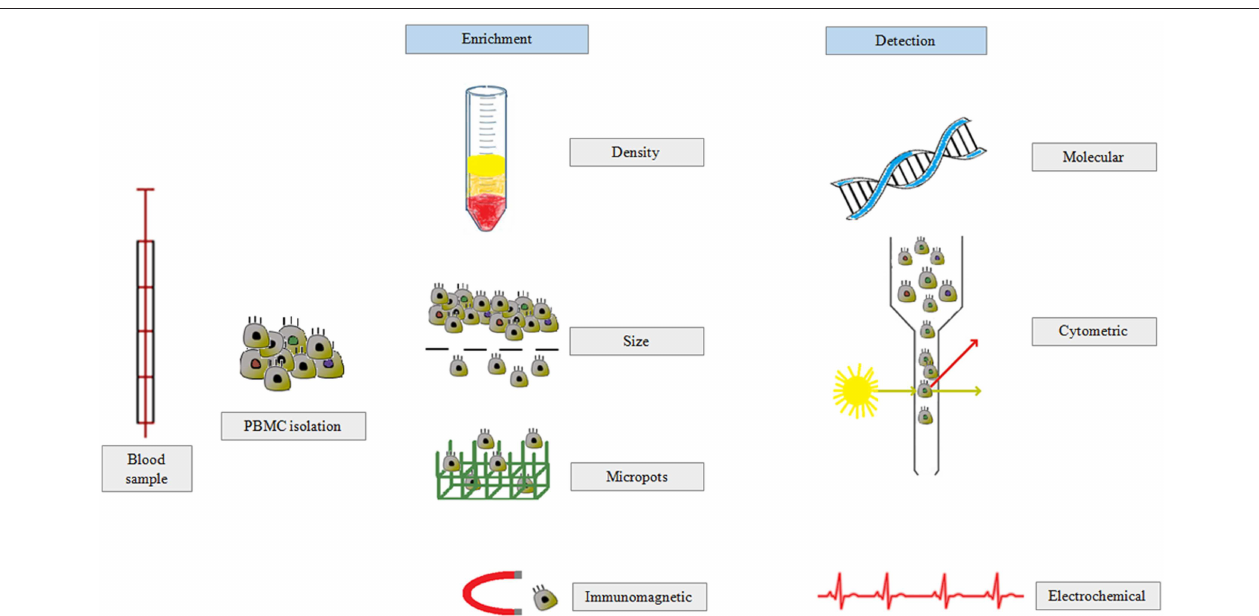
FIGURE 4 | CTCs are isolated from peripheral blood in three main steps: (i) separation of peripheral blood mononuclear cells, (ii) enrichment of CTC population based on density, size, or antibody expression, and (iii) CTC detection by molecular biology, flow cytometry, or electrochemical